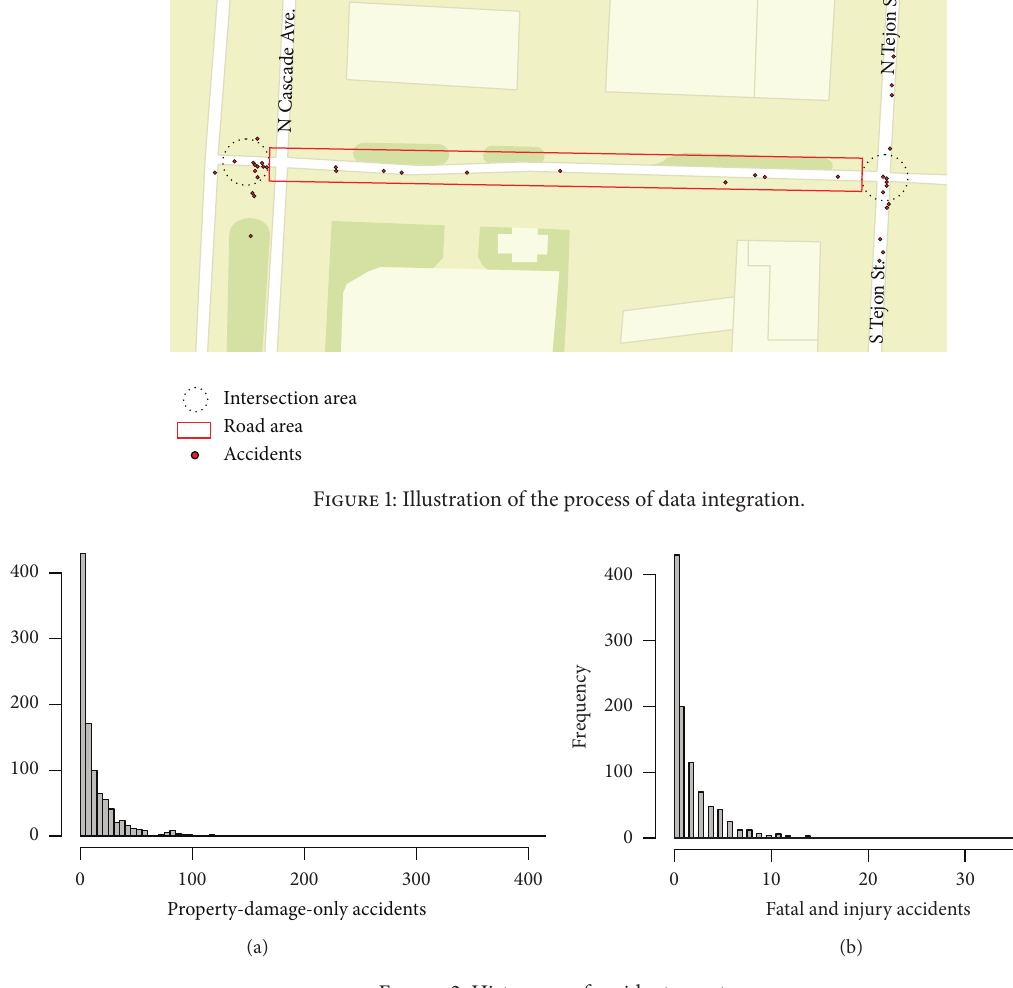
Figure 2: Histogram of accident counts. Table 1: Descriptive characteristic for key